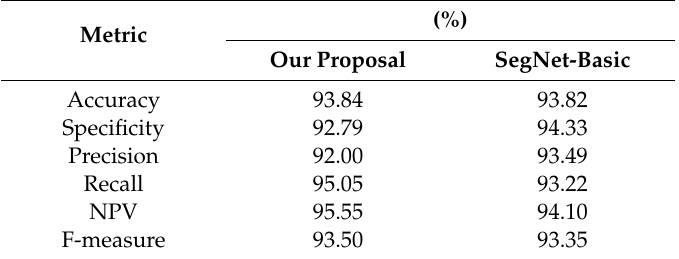
Table 6. Performance of crop segmentation in Test set.